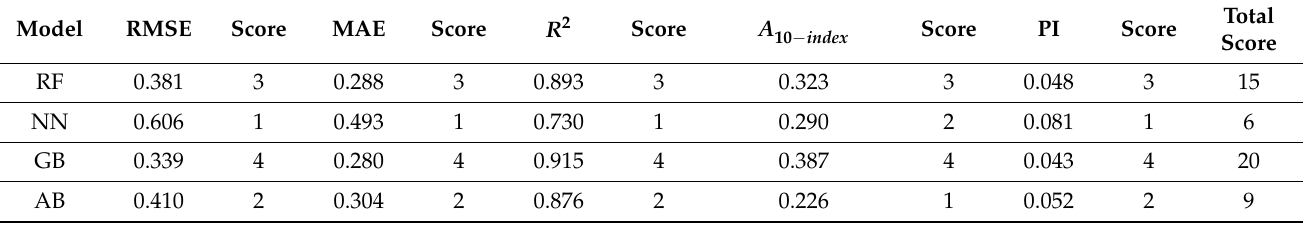
Table 12 . Comprehensive evaluation of ML models.